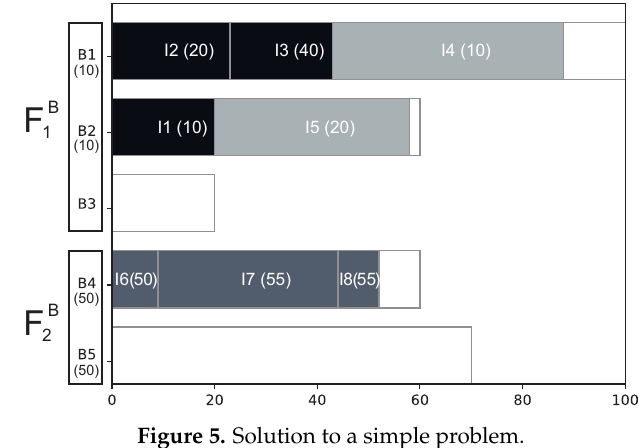
Figure 5. Solution to a simple problem.